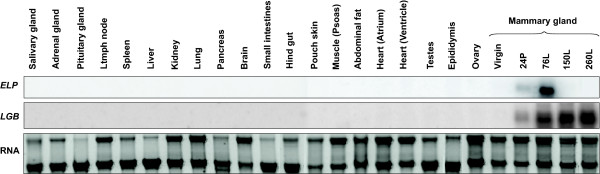
TammarELPexpression was specific to the mammary gland. Northern analysis of total RNA (10 μg) extracted from assorted tammar tissues indicated that both ELP and LGB expression were specific to the mammary gland. Ribosomal RNA bands indicate RNA integrity and loading.